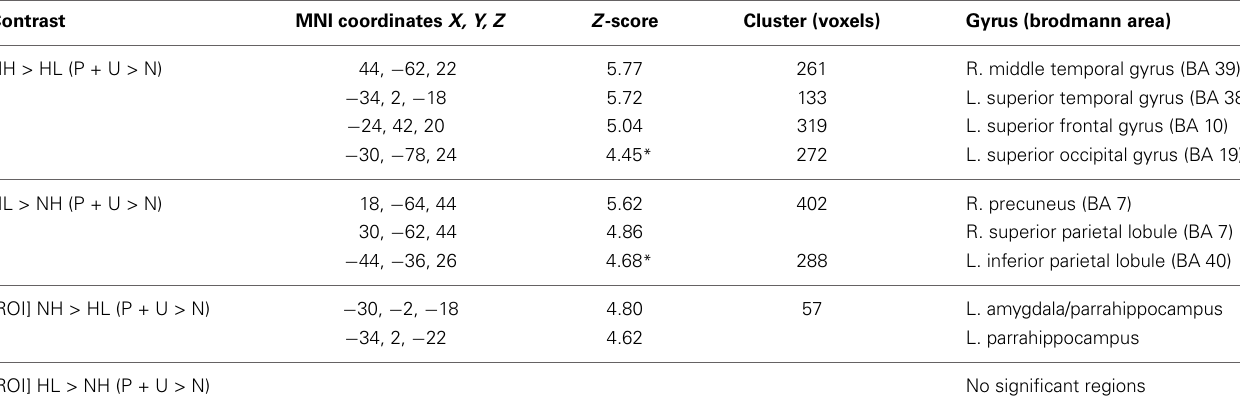
Table 4 | Local maxima for the P + U > N contrasts from the emotion task for the group comparisons. Contrast MNI coordinates X, Y, Z Z -score Cluster (voxels) Gyrus (brodmann area) NH > HL (P + U >